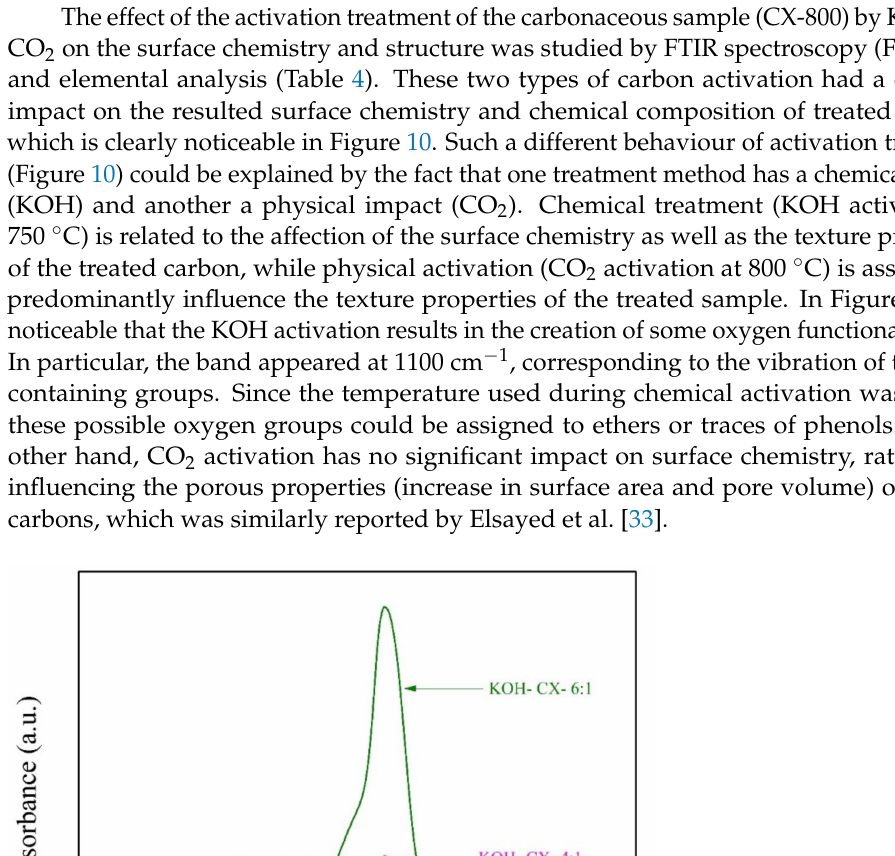
Figure 9. SEM images of ( a ) CO 2 -CX-6h, ( b ) CX carbonised at 800 ◦ C, and ( c ) KOH-CX-6:1.